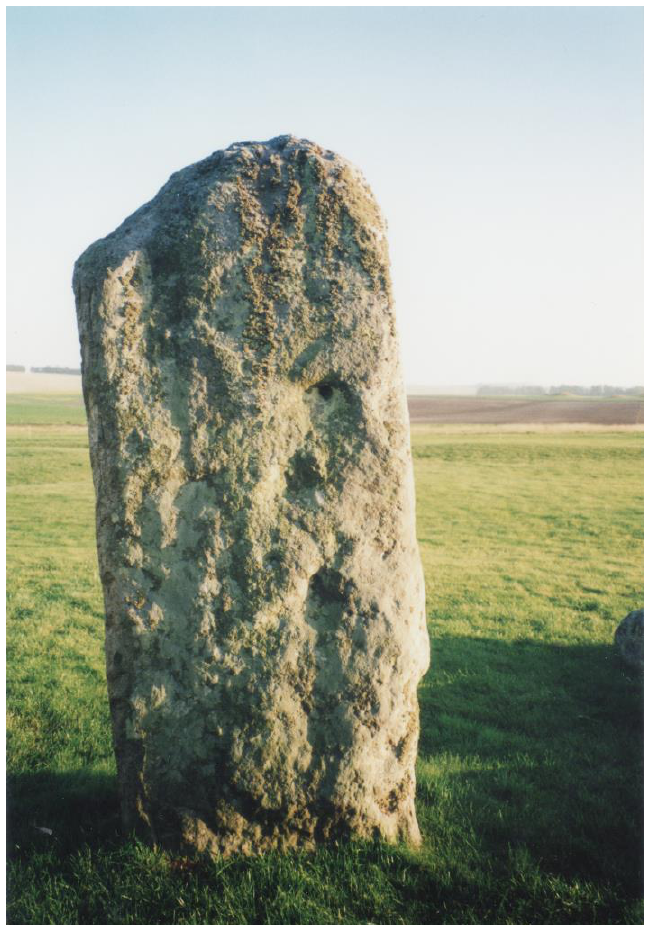
Figure 9. The short rounded Stone 11 (next to the bigger Stone 10) stands slightly offset from the true perimeter of the outer ring of tall standing sarsen stones (compare with the plan in Figure 7) and is only half their height and half their width. (Photograph by the author an hour after sunrise on 31 August